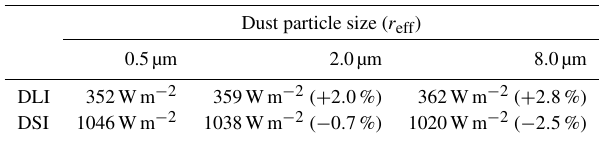
Figure 12. Calculated DSI error at the surface computed with the LFLRT model due to the error in AODs. AOD is assumed to be 0.09. The respective light and dark orange shading indicate positive and negative errors (in Wm − 2 ; left axis) due to 100% AOD errors. The shaded areas are computed with AODs of 0.0 (a − 100% error) and 0.18 (a + 100% error) at the same solar zenith angles, representing 100% error bounds. Values on the solid black line are calculated DSI (right axis) with an AOD of 0.09 at six solar zenith angles. Table 6. The effect of dust particle size on surface irradiance calculations ∗